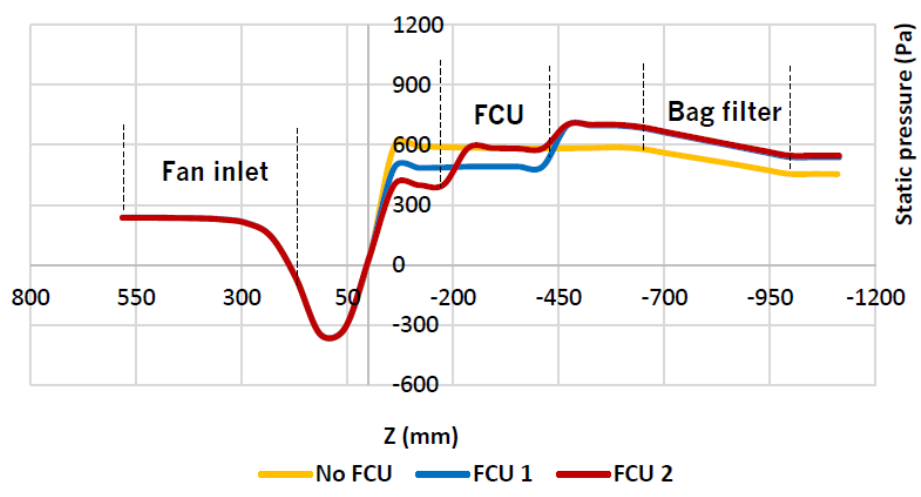
Figure 9. Static pressure curves obtained with and without FCU, under real conditions.